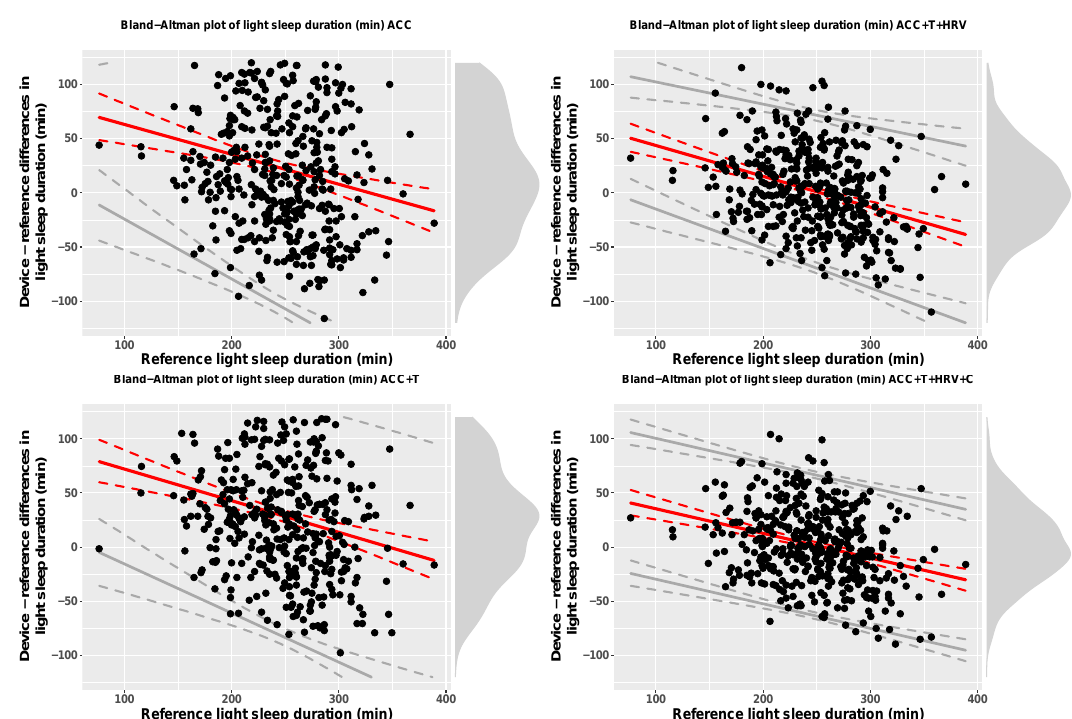
Figure 8. Bias and limits of agreement for time in light sleep, 4-stage classification, and the four models analyzed in this paper.